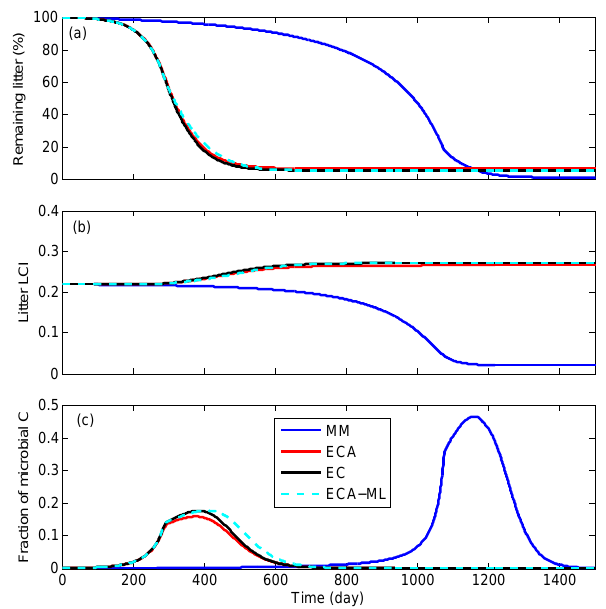
Fig. 10. Time series of state variable ratios simulated from the ap- plication of the four different substrates uptake kinetics to microbial model